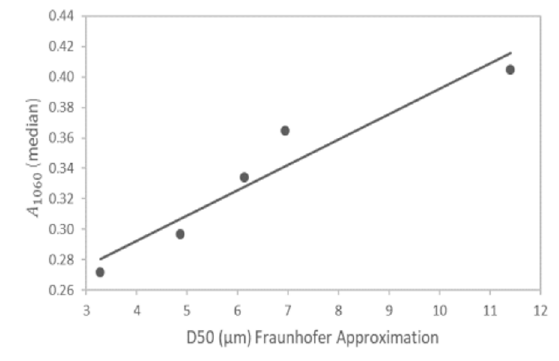
Figure 4. NIRA calibration curve (A ) for 1060 samples particle diameter calculation D50 obtained by the Fraunhofer Approximation.